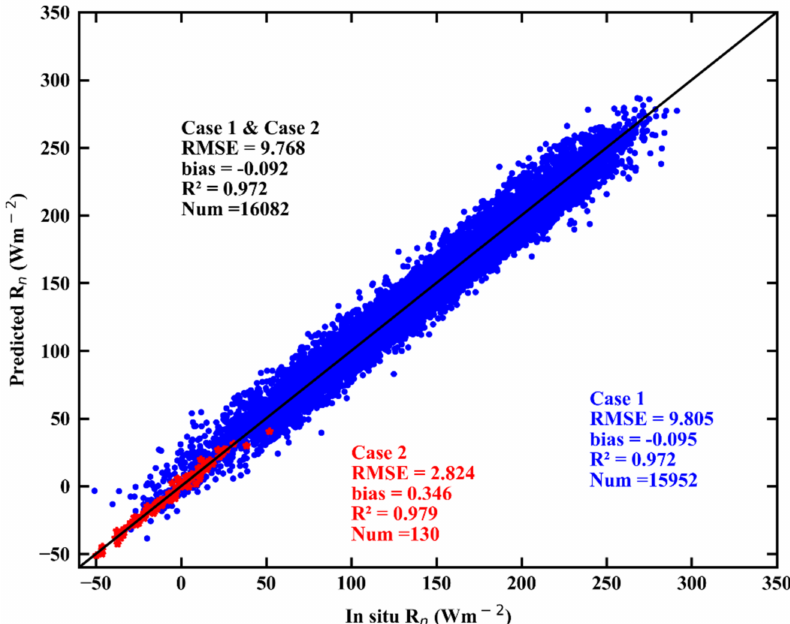
Figure 11. Overall validation results of the newly developed models.